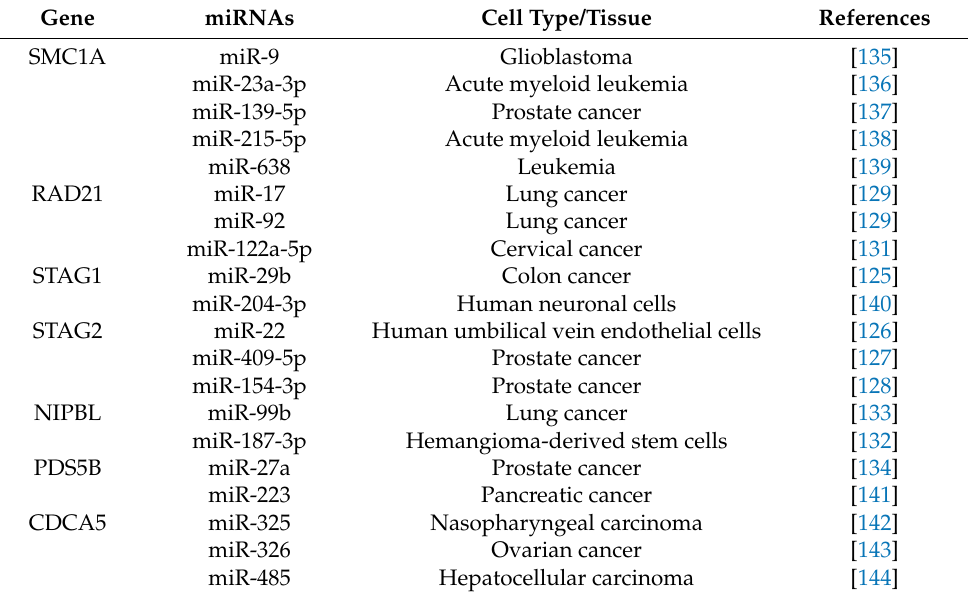
Table 1. Experimentally confirmed miRNAs targeting components of the cohesin complex and additional accessory proteins involved in cohesion